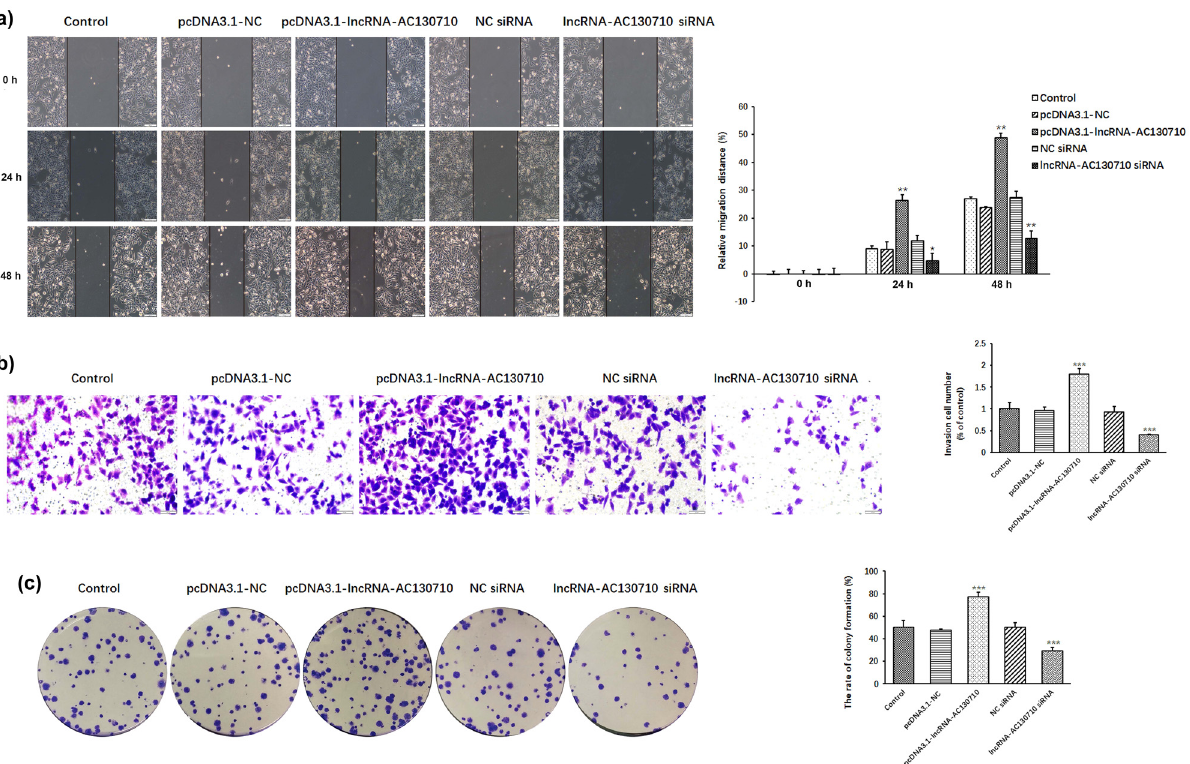
Figure 4: E ff ects of lncRNA - AC130710 on the migration, invasion and clonal formation of A375 cells. ( a ) Cell migration was investigated by wound healing scratch assay in A375 cells transfected with pcDNA3.1 - lncRNA - AC130710 and lncRNA - AC130710 siRNA vectors. ( b )